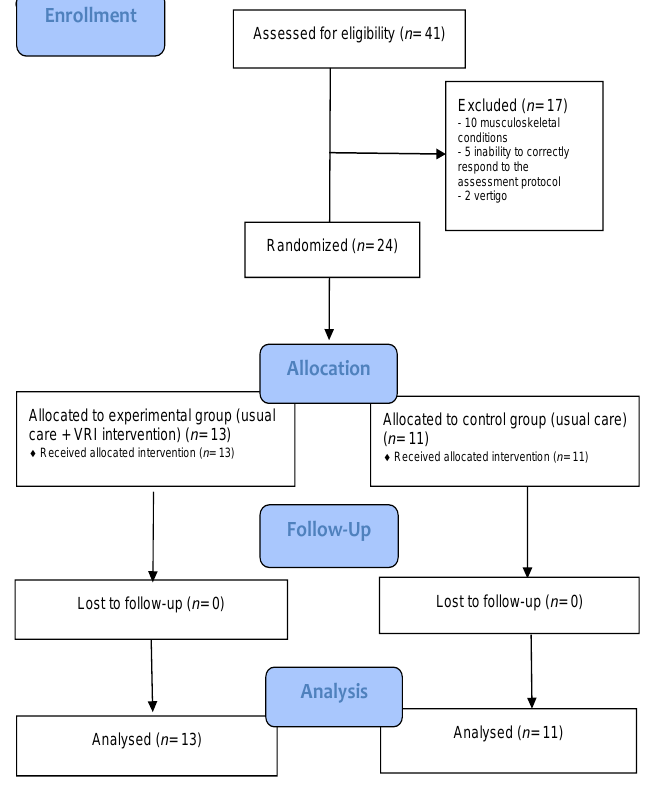
Figure 1. Study design: CONSORT 2010 Flow Diagram. Table 1. Demographic characteristics of the